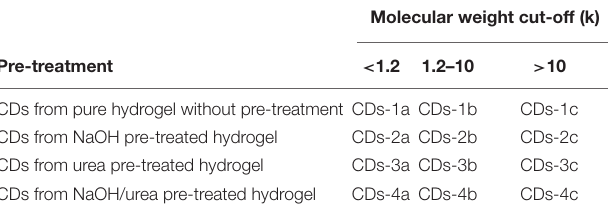
TABLE 1 | Samples name of CDs with different treatment.